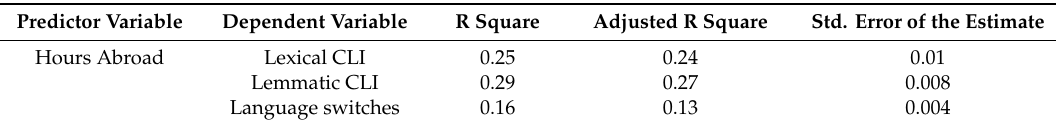
Table 4. Multiple Linear Regression. Predictor variable: Hours abroad. Dependent variables: lexical CLI, lemmatic CLI, language switches.